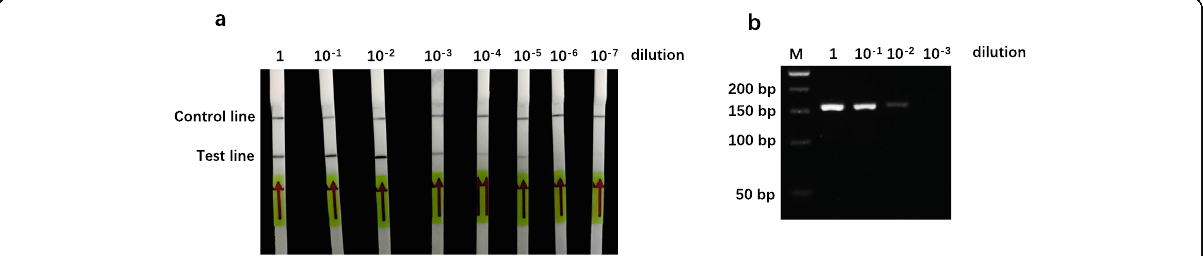
Fig. 2 Comparison of the sensitivity of RPA-LFD and PCR assay for the detection of BCMV. a Detection of BCMV from 10-fold serial dilutions of cDNA samples from BCMV-infected soybean by RPA-LFD. b Detection of BCMV from 10-fold serial dilutions of the same cDNA samples as in a by PCR